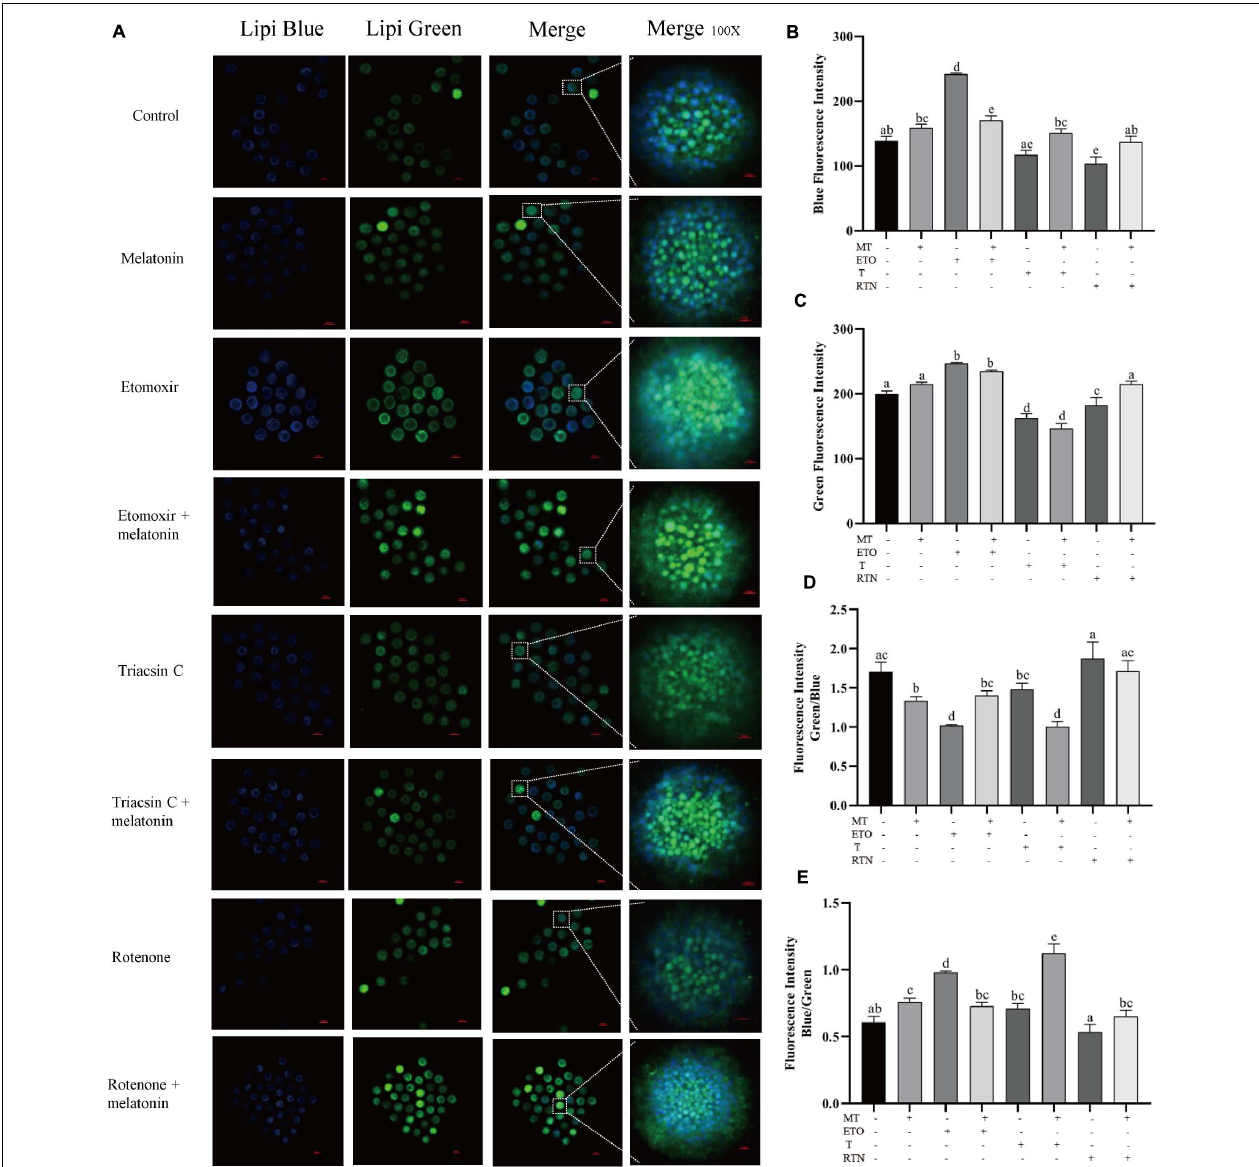
FIGURE 2 | Melatonin modulates lipid metabolism in oocytes. (A) Representative images of Lipi-Blue fluorescence (blue) and Lipi-Green fluorescence (green) in porcine oocytes stained in GV stage but pictured in MII stage. Scale bar: 100 µ m. (B–E) Quantification of fluorescence intensity of Lipi-Blue and Lipi-Green and the ratio of Lipi-Blue/Lipi-Green or Lipi-Green/Lipi-Blue in porcine oocytes treated with control ( n = 57), melatonin ( n = 27), etomoxir ( n = 21), etomoxir + melatonin ( n = 25), triacsin C ( n = 27), triacsin C + melatonin ( n = 30), rotenone ( n = 19), and rotenone + melatonin ( n = 35). Student’s t -test and one-way ANOVA were utilized for statistical analyses. Different lowercase letters indicate significant differences. Error bars indicate